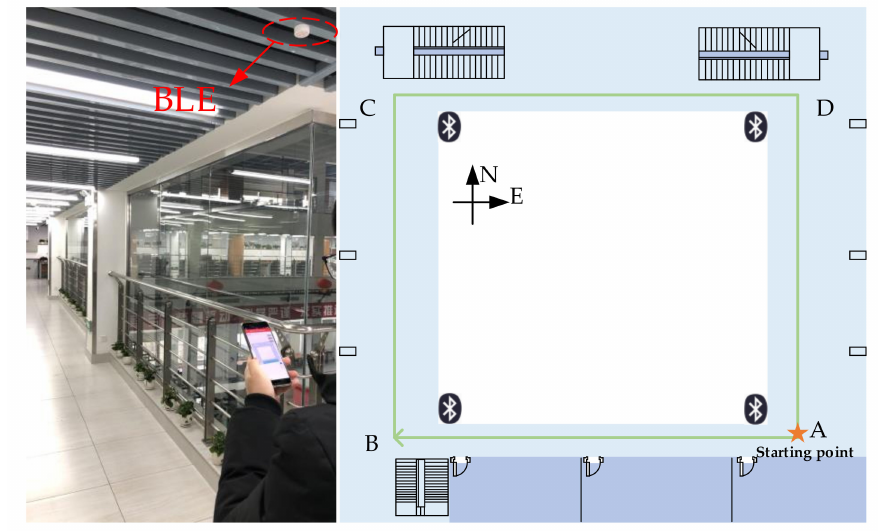
Figure 14. Large scale indoor test